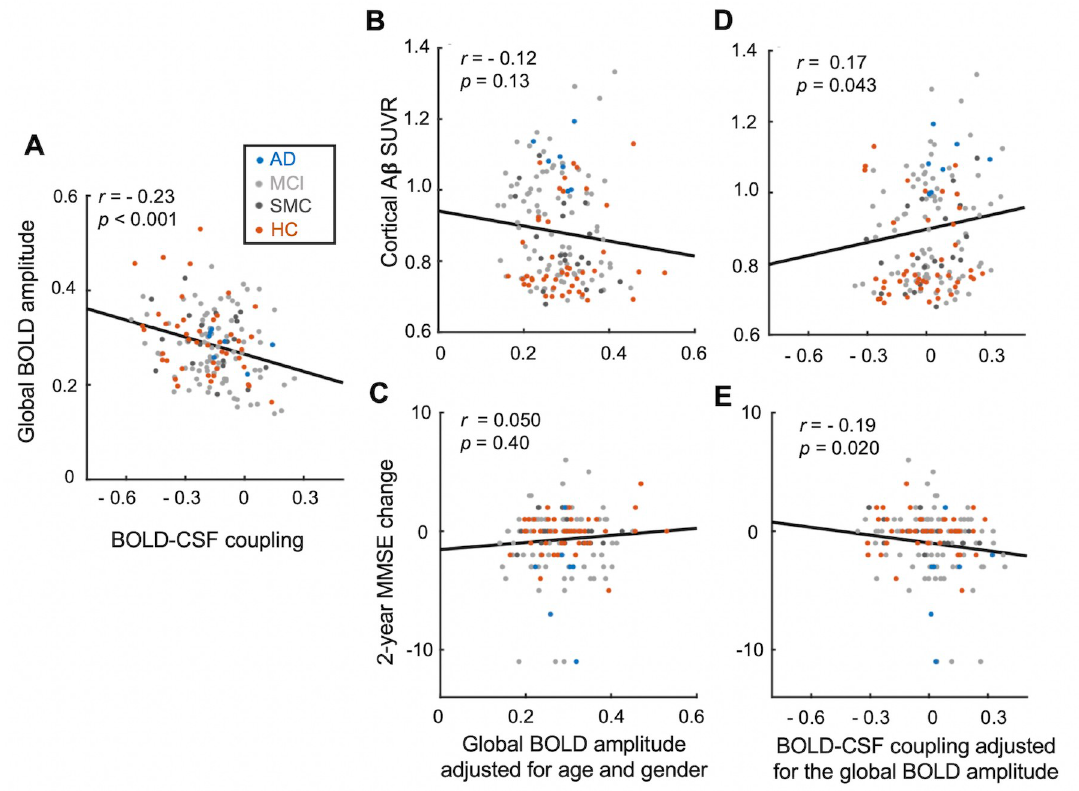
Fig 4. The role of global BOLD amplitude in the associations between BOLD–CSF coupling and AD-related markers. ( A ) The strength of the BOLD–CSF coupling is dependent (Spearman’s r = − 0.23, p < 0.001, N = 158 sessions) on the fluctuation amplitude of the global BOLD signal after adjusting for age and gender. ( B , C ) The amplitude of the global BOLD signal, adjusted for age and gender, is not significantly correlated ( p > 0.13) with either the cortical A β level ( B ) or the 2-year longitudinal change of MMSE score ( C ). ( D , E ) The BOLD–CSF coupling remains significantly correlated (p < 0.05) with the cortical A β level ( D ) and the MMSE changes ( E ) after adjusting for age, gender, and global BOLD amplitude. Each dot represents a single session. AD, MCI, SMC, and HC sessions are colored with blue, light gray, dark gray, and orange, respectively. The data underlying this figure can be found in S1 Data. A β , amyloid- β ; AD, Alzheimer disease; BOLD, blood oxygen level–dependent; CSF, cerebrospinal fluid; HC, healthy control; MCI, mild cognitive impairment; MMSE, Mini-Mental State Examination; SMC, significant memory concern; SUVR, standardized uptake value